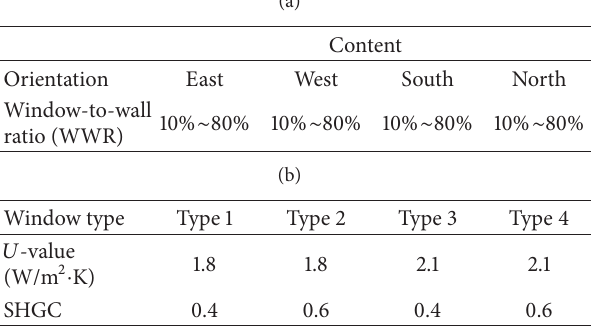
Table 2: Design elements for the selection of window